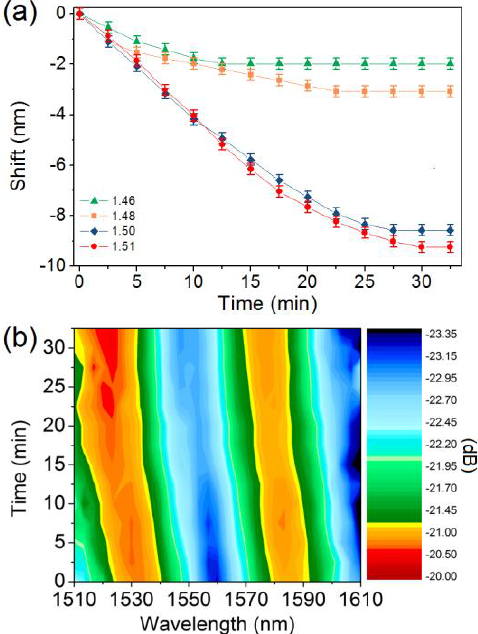
Figure 5. ( a ) Wavelength shift versus immersion time in the oily sample, of the 1563 nm notch of the FP resonator, for four oils with different refractive indices from series A1; ( b ) contour graph of the wavelength shift of a single FP notch for 1.51 refractive index oil. The error bars present the resolution of the optical spectrum analyzer during the recording of the measurements.